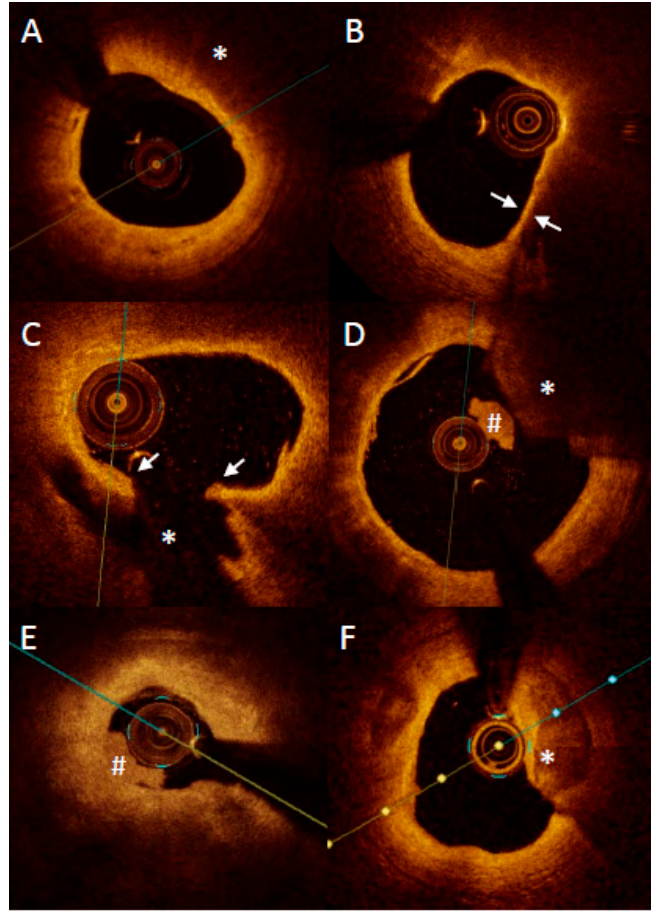
Figure 4. Representative images of optical coherence tomography findings in patients with acute myocardial infarction. Lipid plaque is characterized as signa poor regions (asterisk) with overlying signal-rich bands ( A ). Thin-cap fibroatheroma is defined as a lipid plaque occupying more than >90° in circumference and with fibrous cap thickness (arrows) less than a set threshold (usually 65 μ m or 80 μ m) ( B ). Plaque rupture is defined as disruption of fibrous cap (arrows) with visible cavity within the plaque ( C ; asterisk). Red thrombus is described as highly backscattering structure with high attenuation ( D ; asterisk), whereas white thrombus is less backscattering and has lower attenuation ( D , E ; #). Erosion is described as presence of attached thrombus (usually white; #) overlying an intact and visualized plaque ( E ). Calcification protruding to the lumen is described as calcific nodule ( F ; asterisk).